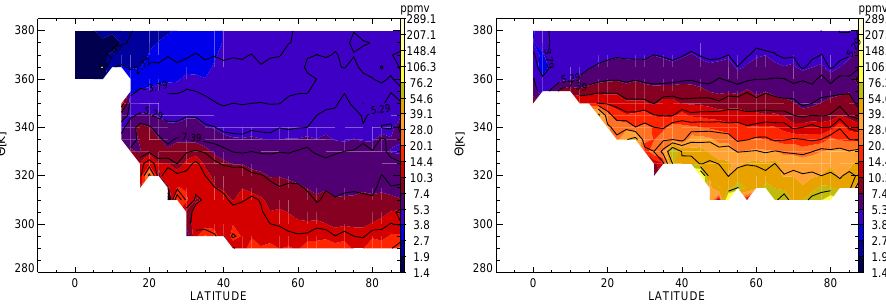
Fig. 9. Mean saturation mixing ratio of the TST trajectories according to their LCP and non-TST trajectories, assuming 5 ppmv H 2 O for stratospheric background for northern winter (left) and summer (right), colours as in Fig. 8. Contours show the H 2 O LCP , sat from Fig. 8 for comparison.